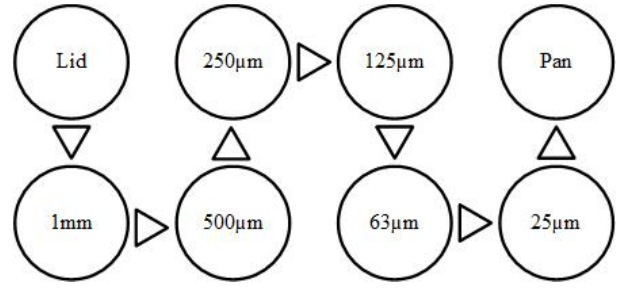
Figure 1. Schematic arrangements of sieves for sand sieving .